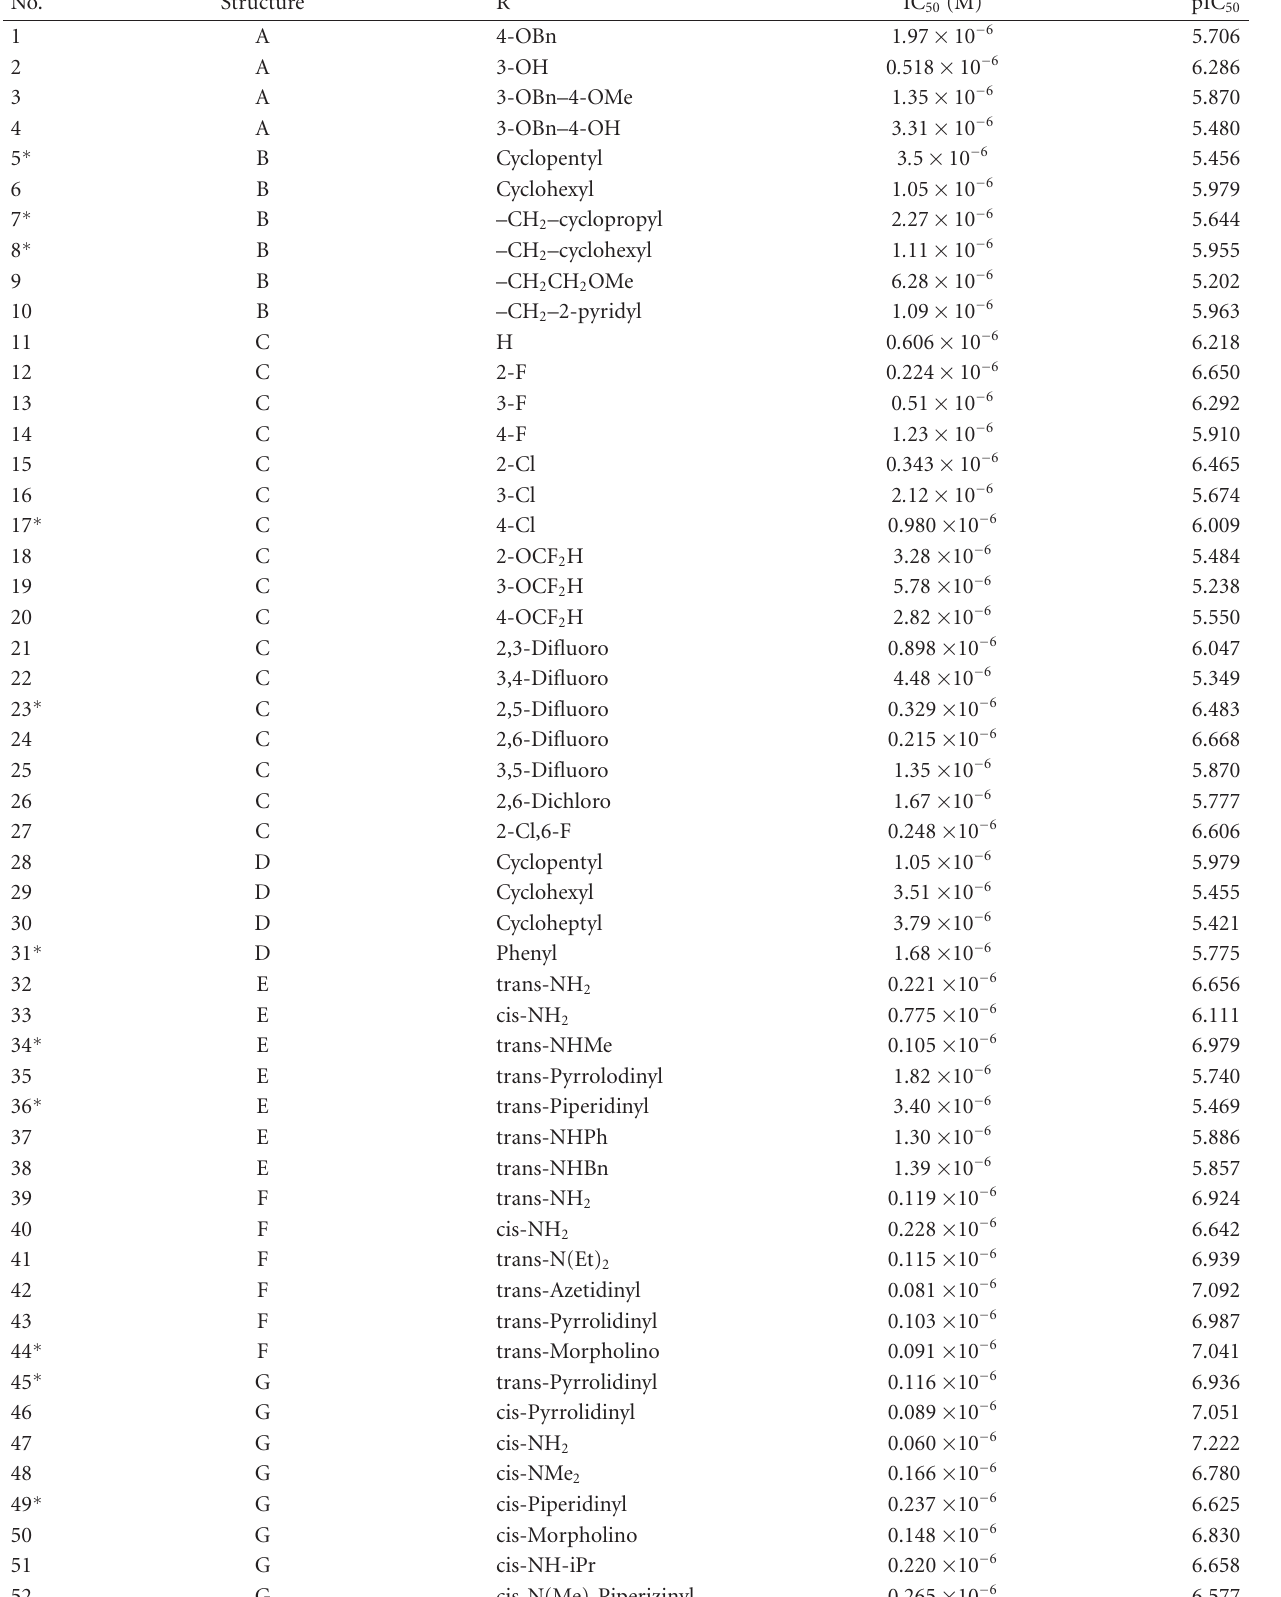
Table 1: The structures and observed IGF inhibitory activities